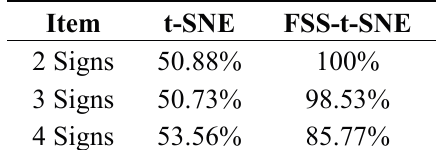
Table 1. Classification accuracy by KNN classifier.